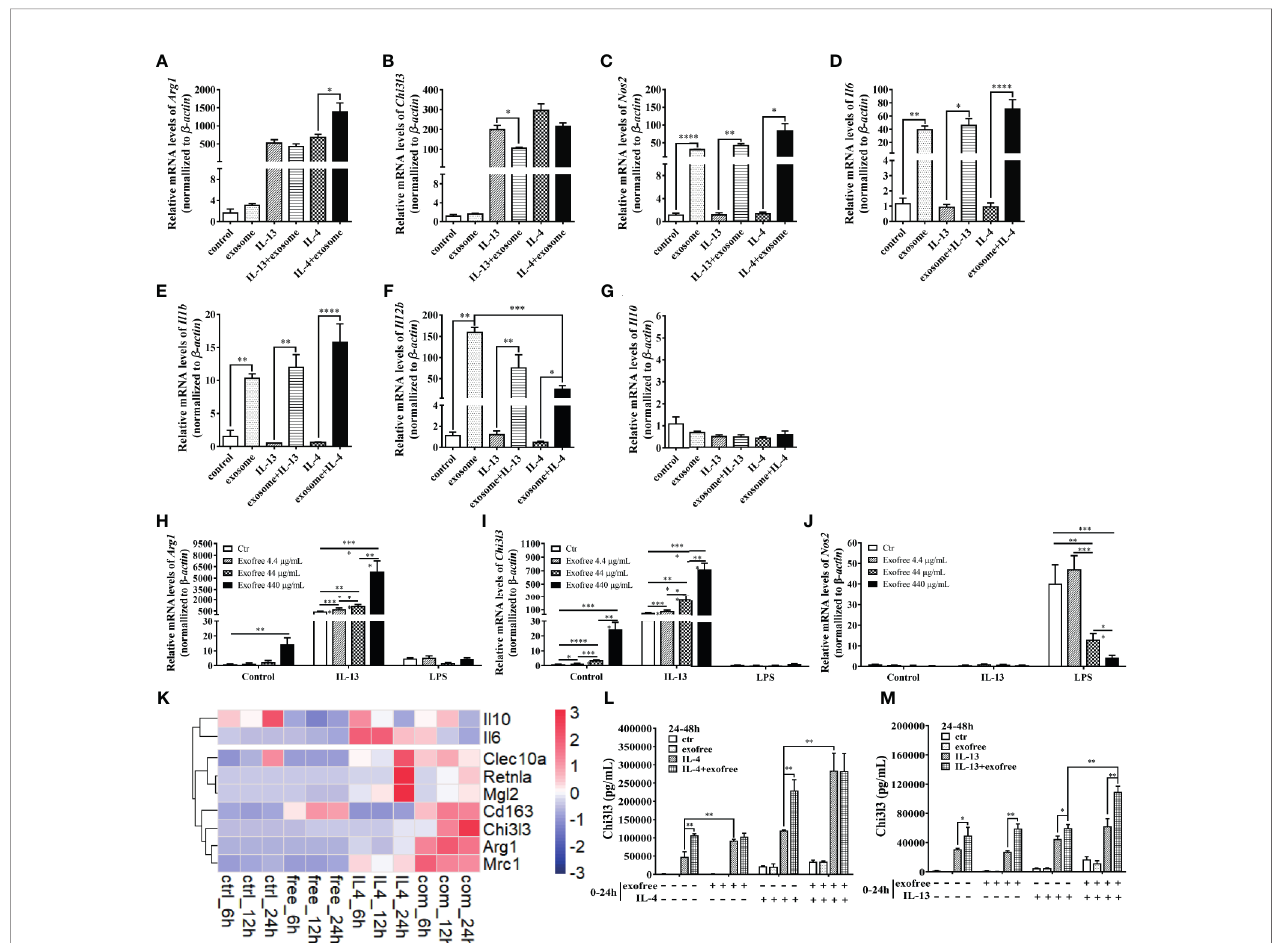
FIGURE 3 | AC L4 exofree could promote a M2 polarization, while AC L4 exosomes induce M1 polarization of macrophage. (A – G) Macrophage activation markers Arg1 (A) , Chi3l3 (B) , Nos2 (C) , and related interleukins Il6 (D) , Il1b (E) , Il12b (F), and Il10 (G) expression level were measured in the presence of AC L4 exosome, IL-4, IL-4+exosome, IL-13, and IL-13+exosome for 24 h using qPCR. The working concentration of AC L4 exosome is 25 m g/ml. The working concentration of IL-13 and IL-4 is 10 ng/ml. (H – J) Macrophage activation markers Arg1 (H) , Chi3l3 (I) , Nos2 (J) were measured in the presence of exofree, IL-4, IL-4+exofree, IL-13, and IL-13+exofree for 24 h using qPCR. (K) Signature gene expression pro fi le of macrophage in the presence of PBS (ctr), free (AC L4 exofree), IL-4, com (IL-4+AC L4 exofree), and 6, 12, and 24 h represent 6, 12, and 24 h after the treatment, respectively. The working concentration of AC L4 exofree is 440 m g/ml. The working concentration of IL-13/IL-4 is 10 ng/ml. The working concentration of LPS is 0.05 m g/ml. The horizontal axis represents genes, and vertical coordinates represent types of treatment. (L, M) BMDMs were stimulated with PBS, AC L4 exofree, IL-4, IL-4+ AC L4 exofree, IL-13, IL-13+ AC L4 exofree in 0~24 h The culture medium was discarded. BMDMs were then washed with PBS and restimulated in 24~48 h as shown. And Chi3l3 protein level of 24~48 h culture medium was measured using ELISA. The working concentration of AC L4 exofree is 440 m g/ml. The working concentration of IL-13/IL-4 is 10 ng/ml. The detailed experiment